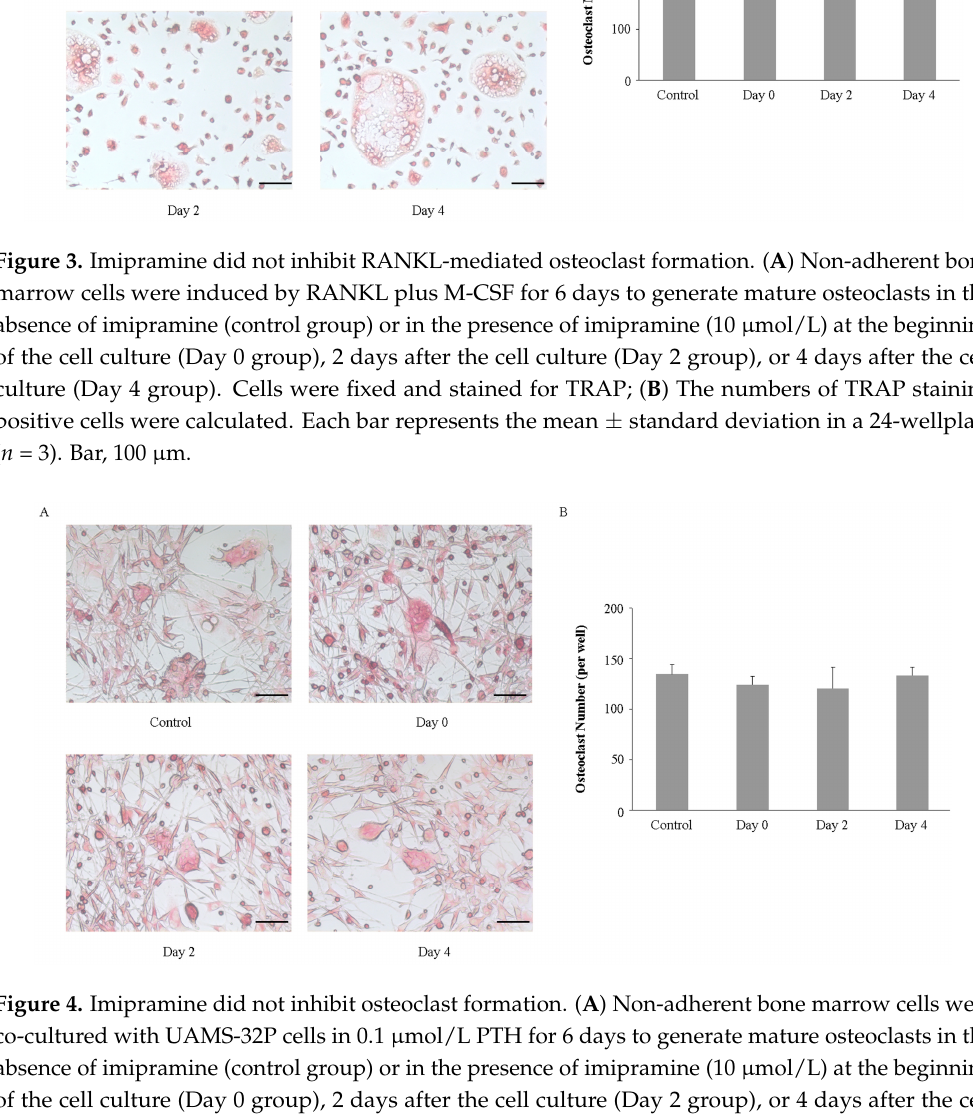
Figure 4. Imipramine did not inhibit osteoclast formation. ( A ) Non-adherent bone marrow cells were co-cultured with UAMS-32P cells in 0.1 µmol/L PTH for 6 days to generate mature osteoclasts in the absence of imipramine (control group) or in the presence of imipramine (10 µmol/L) at the beginning of the cell culture (Day 0 group), 2 days after the cell culture (Day 2 group), or 4 days after the cell culture (Day 4 group). Cells were fixed and stained for TRAP; ( B ) The numbers of TRAP staining positive cells were calculated. Each bar represents the mean±standard deviation in a 24-wellplate ( n = 3). Bar, 100 µm.